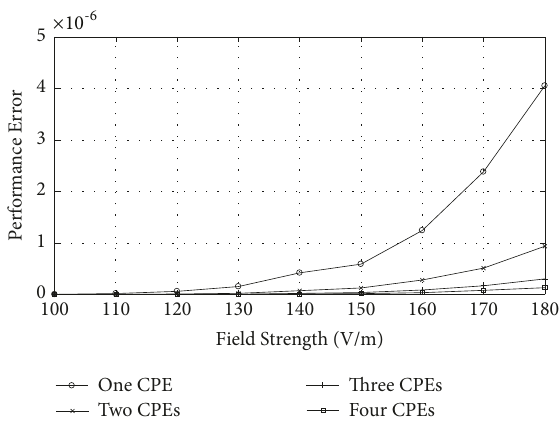
Figure 7: Simulation estimation comparisons of performance error for different redundant structures under different environments modeled by MDHMM.